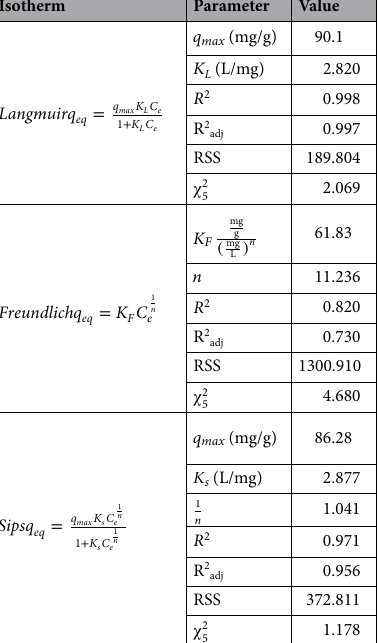
Isotherm Parameter